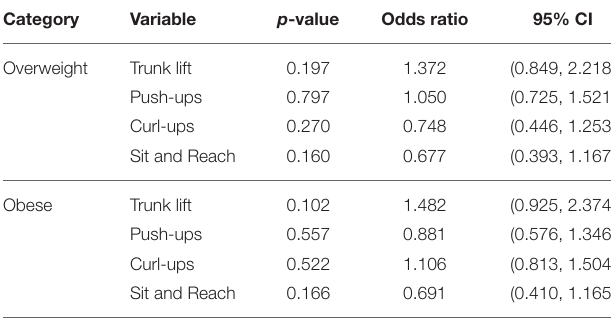
TABLE 4A | Associations between musculoskeletal fitness and weight status in second grade (reference group: healthy weight).